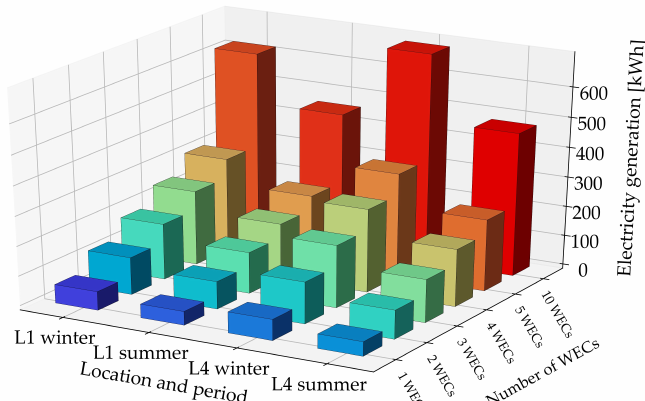
Figure 9. Daily electricity generation for various number of WECs in a WPF on locations L1 and L4, and summer and winter seasons.